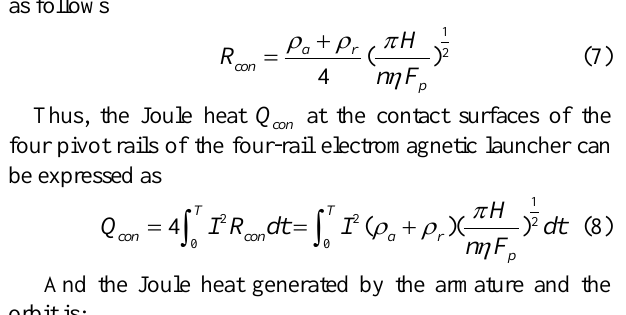
FIGURE 6. Schematic diagram of the maximum temperature variation of electromagnetic launchers of different structures temperature rise rate of the concave rail-convex armature electromagnetic launcher is